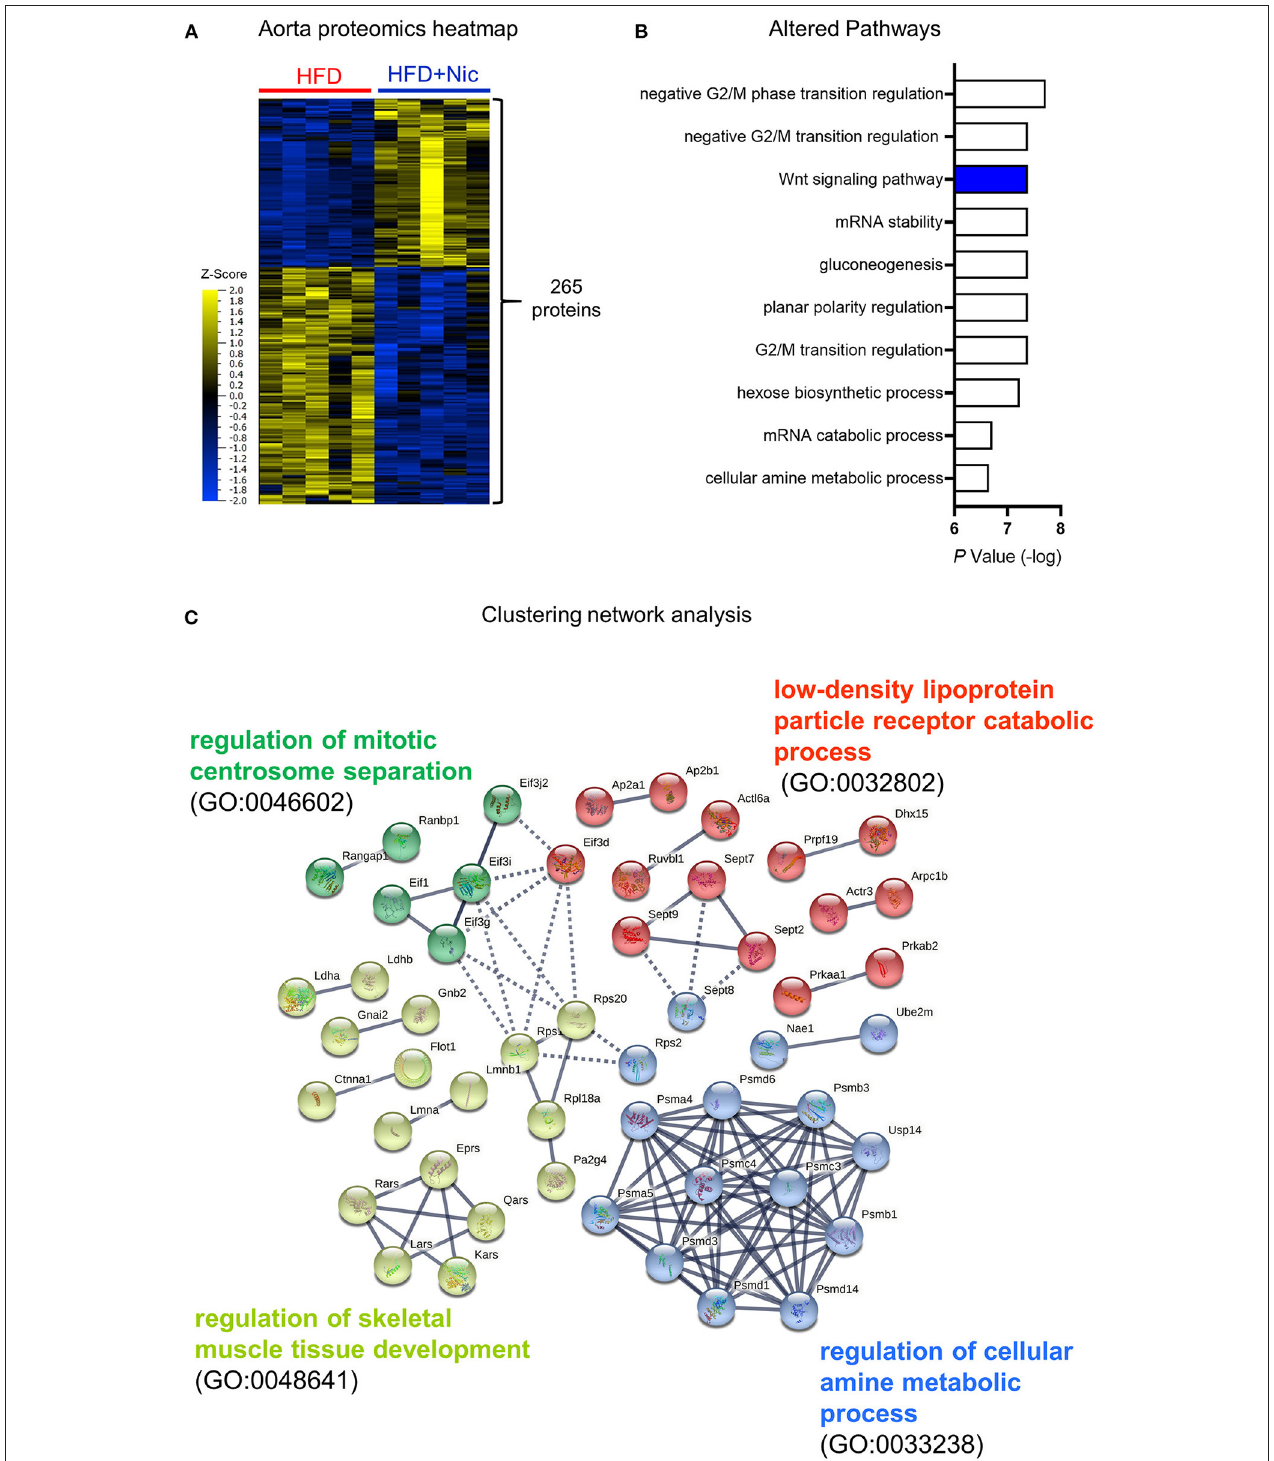
FIGURE 3 | Proteomics and network analysis of aortas of mice treated with Niclosamide. (A) Hierarchical clustering and heat map of proteins that are differentially abundant in the aorta of mice fed a HFD vs. HFD containing niclosamide (a two-group comparison with N = 5 mice per group at terminal sacrifice, analyzed by F- t- test, P < 0.01). (B) Top ranked niclosamide altered pathways using gene ontology resources (GO biology process 2021). (C) Protein-protein (STRING database; showing physical subnetwork) and pathway analysis (Reactome database) including all identified 265 proteins in (A) . Most of Protein nodes in GO:0033238 involve Runx2 regulation and Wnt signaling